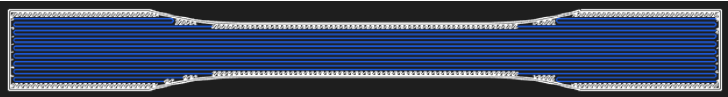
Figure 4. Schematic representative of fiber-reinforced tensile specimen.